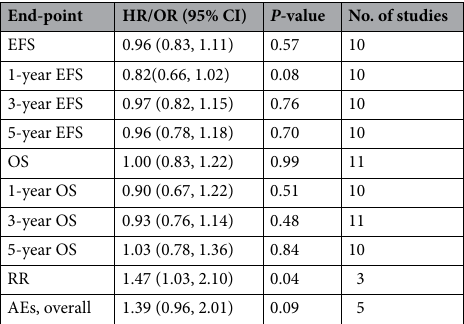
Table 4. Sensitivity analysis in meta-analysis of treatment effect comparing the experimental arms with control arms. Abbreviations: AE, adverse event; CI, confidence interval; EFS, event-free survival; HR, hazard ratio; OR, odds ratio; OS, overall survival; RR, response rate.